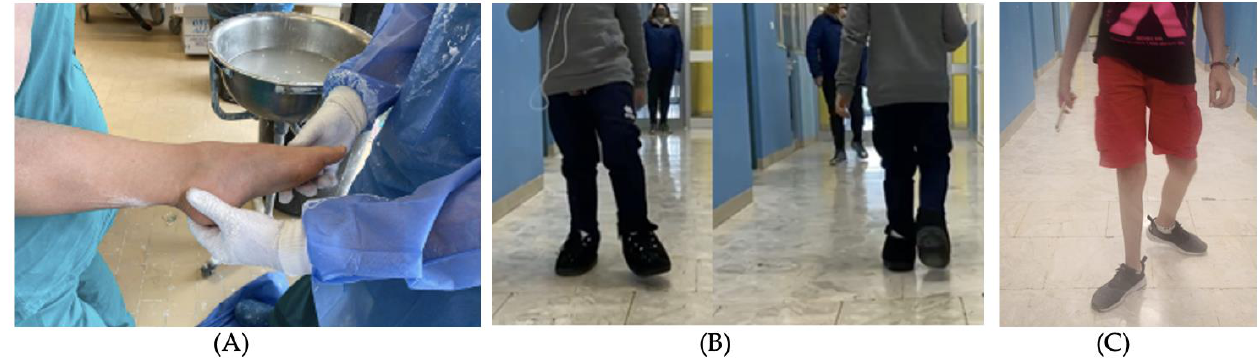
Figure 1. ( A ) Preintervention representation of the participant. ( B ) Participant at 1 week after cast- ing follow-up. ( C ) Participant at 2-year follow-up. follow-up. ( C ) Participant at 2-year follow-up.